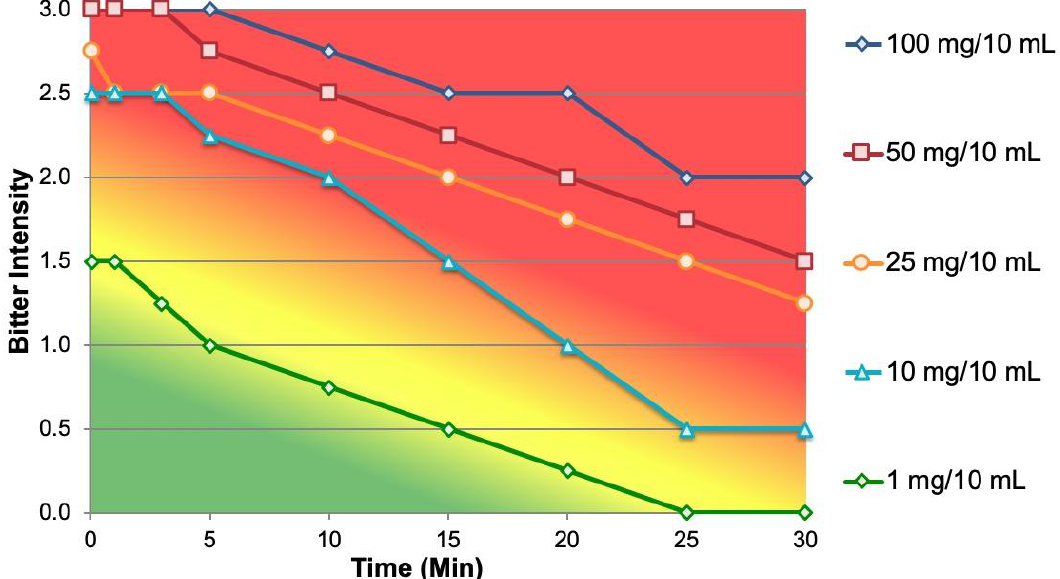
Figure 3. Bitterness dose/response of Norvir® oral powder (NOP).